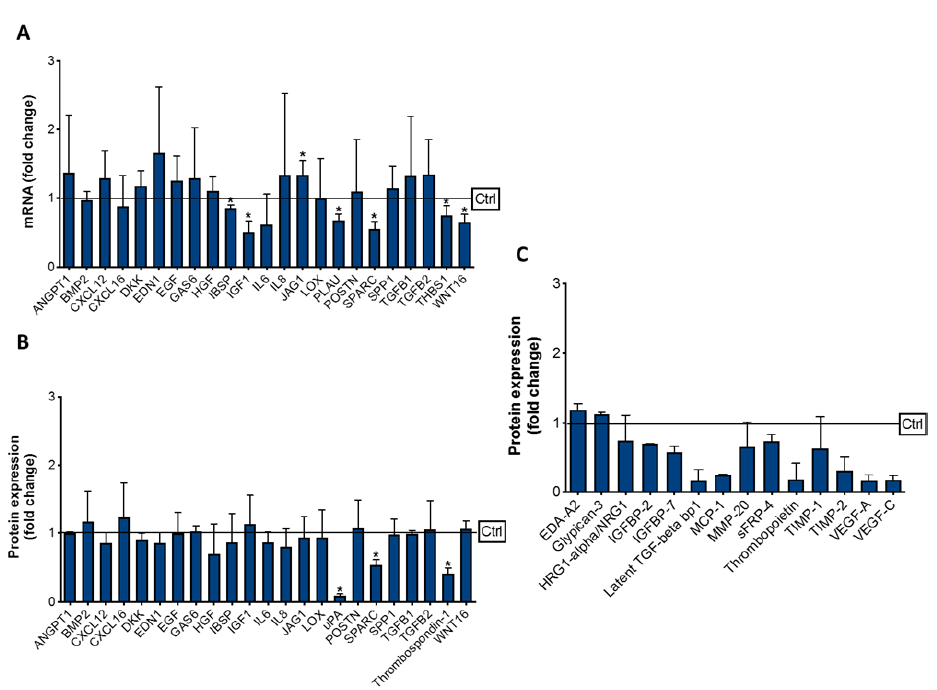
Figure 6. Effect of cabozantinib on the OB molecular profile. The OB gene ( A ) and protein expression ( B ) of selected factors after the cabozantinib treatment (5 μM). ( C ) Other molecules significantly modulated by the cabozantinib treatment. Data are presented as the fold change with respect to the untreated OBs (Ctrl = 1). Data are presented as the mean ± SD; * p ≤ 0.05.